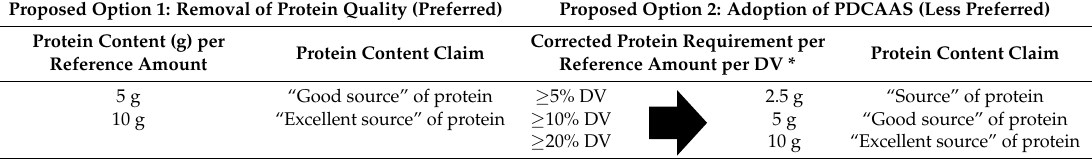
Table 4. An example that demonstrates the current and proposed approaches for qualifying for protein content claims in Canada when ≥ 2 distinct finished foods are traditionally combined prior to consumption . Example from Table 1: Chickpea-based Breakfast Cereal and Milk (2% MF)  High density breakfast cereal ( ≥ 43 g/250 mL) = 55 g RA